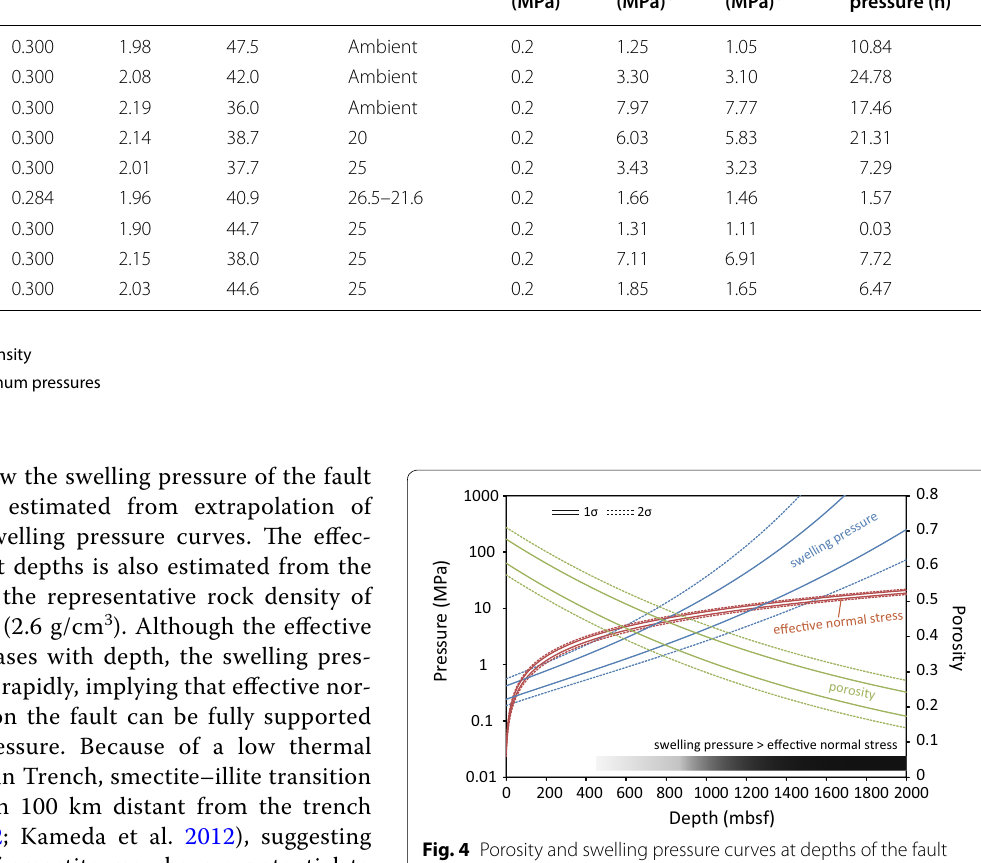
Table 1 Summary of the experiments